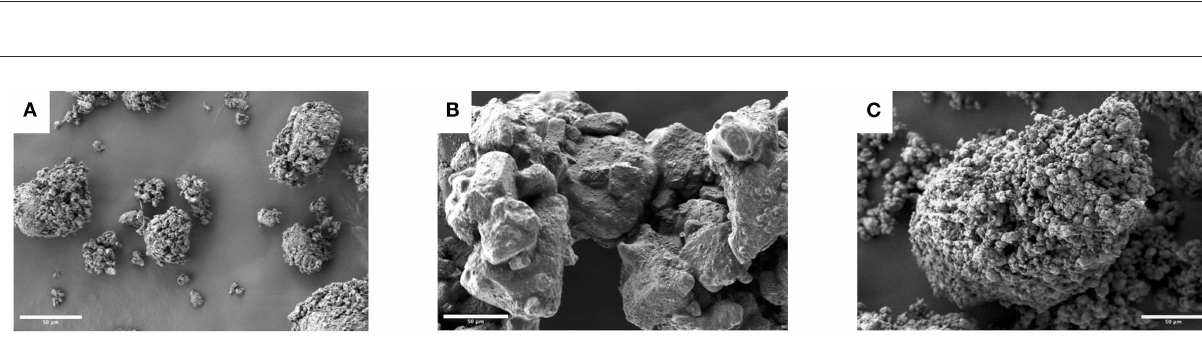
FIGURE2 Scanning electron micrographs of solid carrier excipients coated with the nanoemulsion NE50: (A) mannitol, (B) lactose and (C) calcium carbonate (1,000 × magnification, scale bars: 50 µ